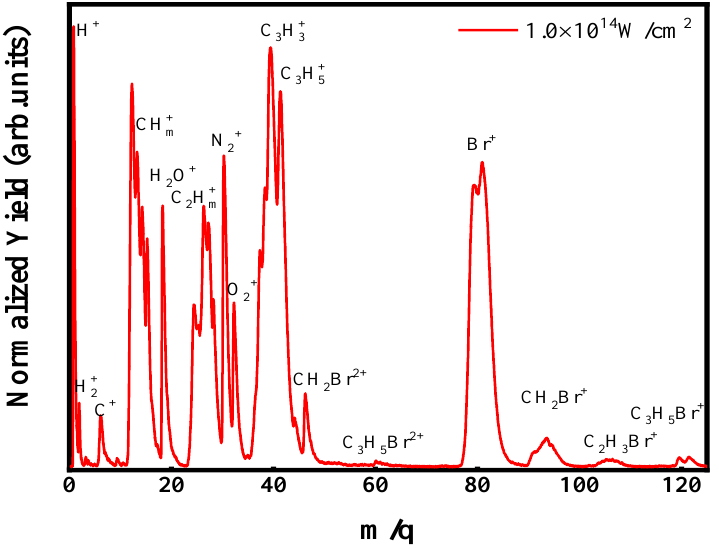
Figure 1. The mass spectrum of BCP molecule irradiated by the femtosecond laser field with the intensity of 1.0 × 10 14 W/cm 2 at 800 nm.